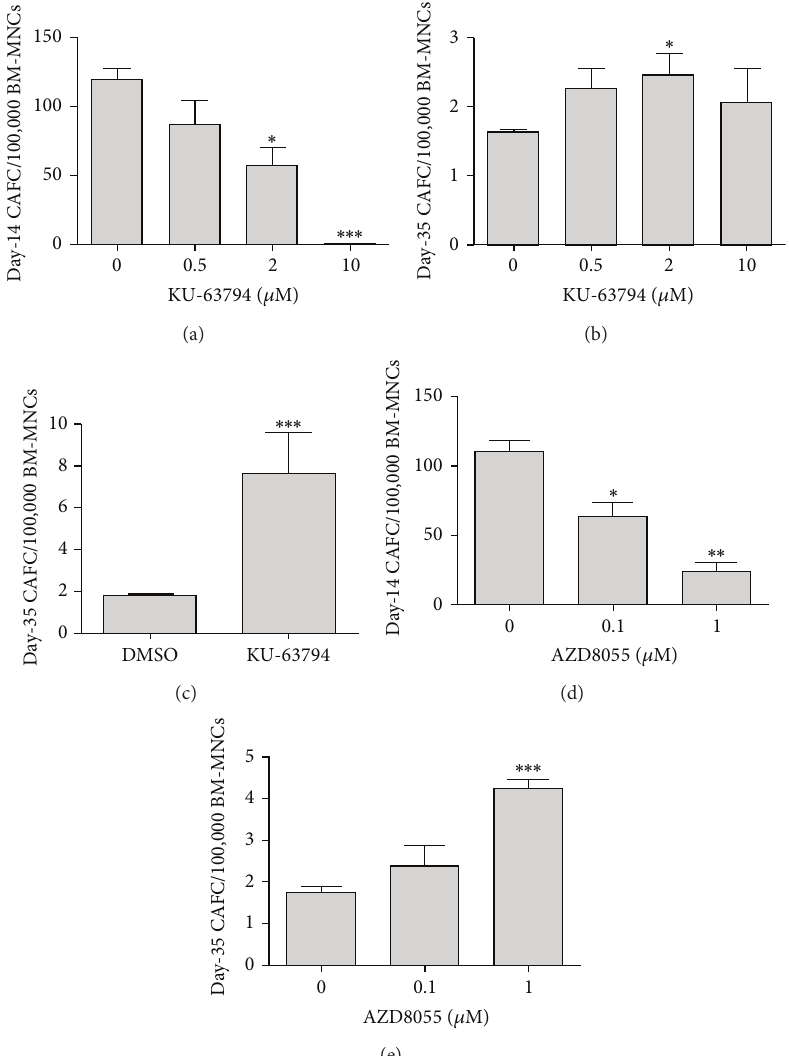
Figure 4: Dual inhibition of mTORC1/2 suppresses day-14 CAFCs but promotes the production of day-35 CAFCs. The functions of HSPCs were determined in vitro using CAFC assays as we previously reported [13–15]. (a) Day-14 CAFCs were analyzed to assess the function of HPCs. (b) Day-35 CAFCs were measured to evaluate the function of HSCs in vitro . (c) Day-35 CAFCs were determined using the same protocol as shown in (b), except that KU-63974 was readded to the culture medium weekly for 4 weeks. (d) Day-14 CAFCs were performed to assess the function of HPCs in the presence of different doses of AZD. (e) Day-35 CAFCs were measured to evaluate the function of HSCs with or without AZD treatment. Data are presented as mean +/ − SEM of three independent experiments. ∗ 𝑝 < 0.05 versus DMSO vehicle control; ∗∗ 𝑝 < 0.01 ; ∗∗∗ 𝑝 < 0.001 versus DMSO vehicle